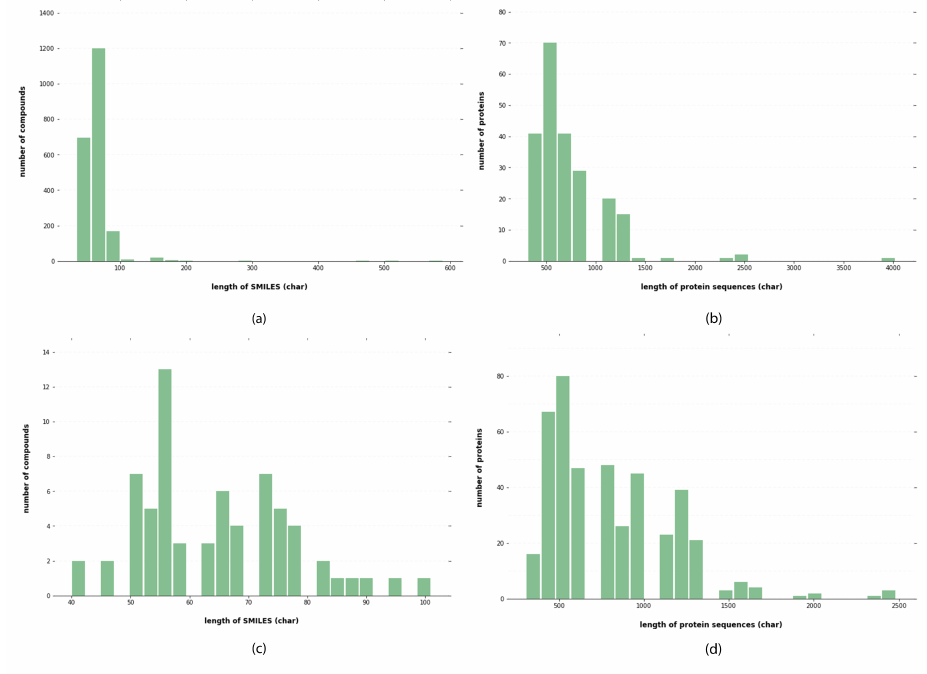
Figure 4. Analysis of KiBA and Davis datasets: ( a ) distribution of length of SMILES for KiBA datasets, ( b ) distribution of length of protein sequences for KiBA datasets, ( c ) distribution of length of SMILES for Davis datasets, and ( d ) distribution of length of protein sequences for Davis